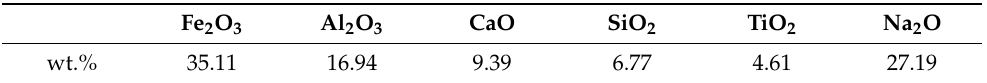
Table 2. Normalized chemical composition of the thermal product after roasting BR and NaOH at 600 °C, under H 2 gas (expressed as oxides).